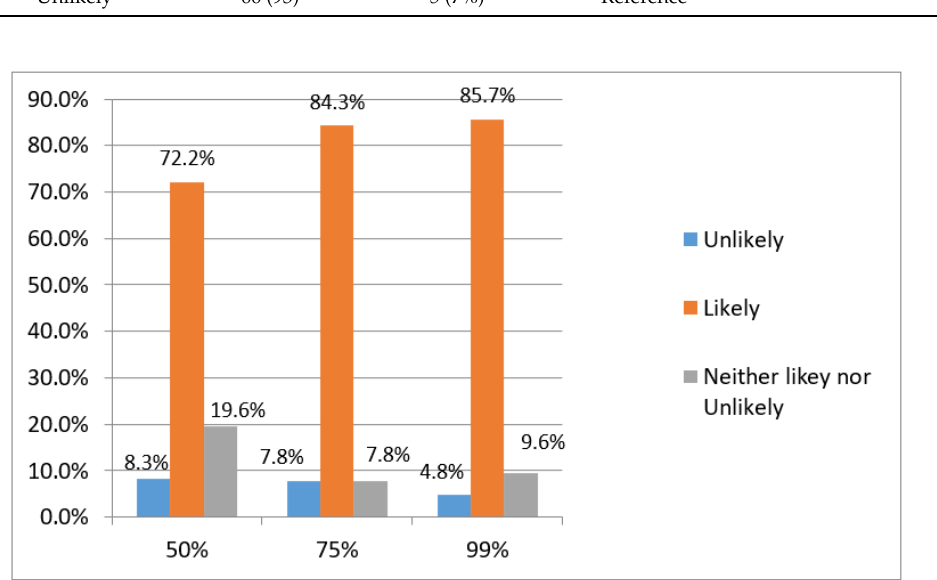
Figure 2. Different levels of vaccine efficacy and participants’ responses on how likely they were to be vaccinated.